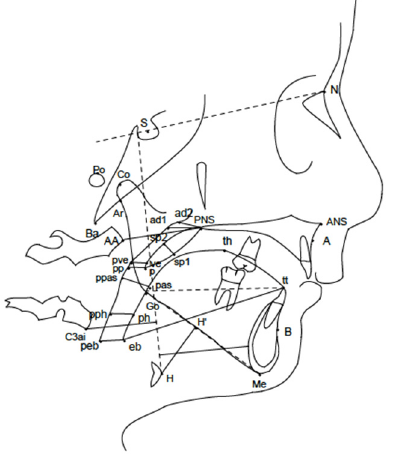
Figure 2. Cephalometric landmarks used for the analysis [7].